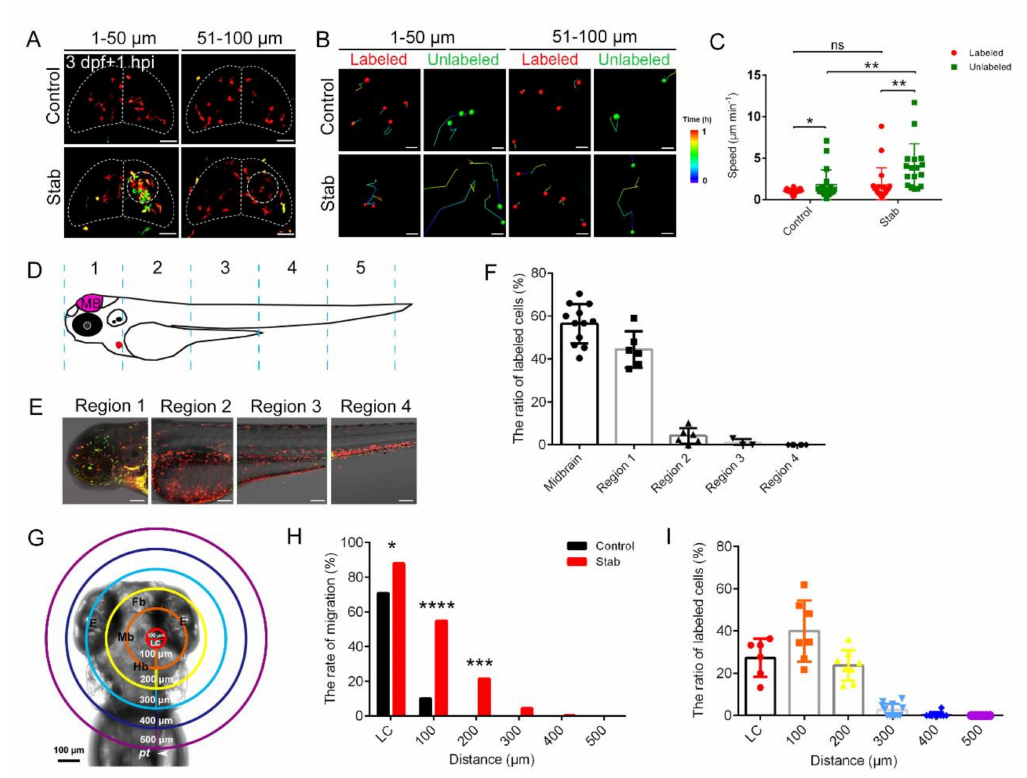
Figure 2. Macrophages around injured regions activated and responded in a distance-dependent manner. ( A ) The aggregated macrophages did not originate solely from the labeled coro1a -Kaede + cells in the midbrain. Live imaging on the coro1a -Kaede + cells in the upper (1–50 µ m from surface, left panels) and deep (51–100 µ m from surface, right panels) layers of Tg(coro1a:Keade) brains. Scale bar, 50 µ m. ( B ) The migration trajectories of macrophages in different layers. Scale bar, 20 µ m. ( C ) Sta- tistical analysis of migration speed of labeled and unlabeled coro1a -Kaede + cells. Control, labeled, 1.03 ± 0.05 µ m min − 1 n = 27; unlabeled, 1.79 ± 0. 42 µ m min − 1 n = 19; Stab, labeled, 1.75 ± 0.46 µ m min − 1 n = 20; unlabeled, 3.95 ± 0. 68 µ m min − 1 n = 17. ( D ) Schematic diagram of regional division of zebrafish body. ( E ) coro1a + cells in each region are labeled separately. Scale bar, 100 µ m. ( F ) The proportion of labeled red coro1a -Kaede + cells from different regions in aggregated cells. ( G ) Model diagram of region divisions at different distance from the LC. LC is a circle 100 microns in diameter at the lesion core. ( H ) The rate of migration of labeled cells in each region moving to the LC. ( I ) The contributing proportion of the cells from different regions to the accumulated macrophages of the honeycomb network configuration. (Data are shown as mean ± SEM. ns , no significance; *, p < 0.05; **, p < 0.01; ***, p < 0.001; ****, p <